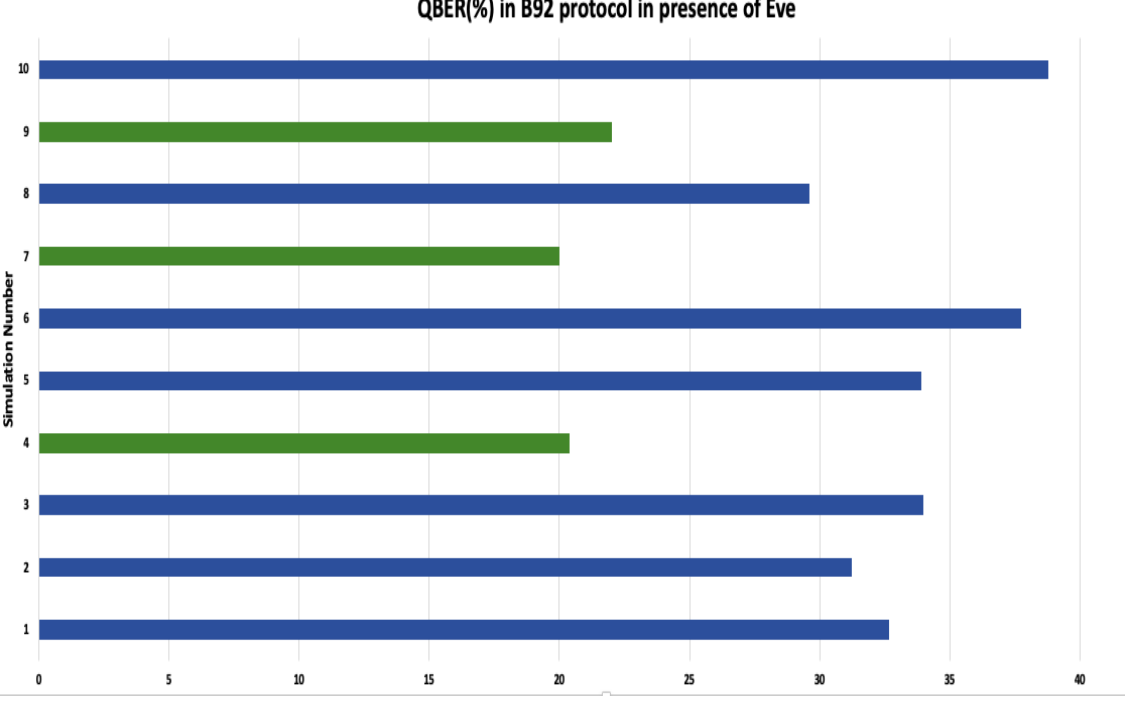
Figure 13. QBER in the presence of an Eve in B92 protocol over 10